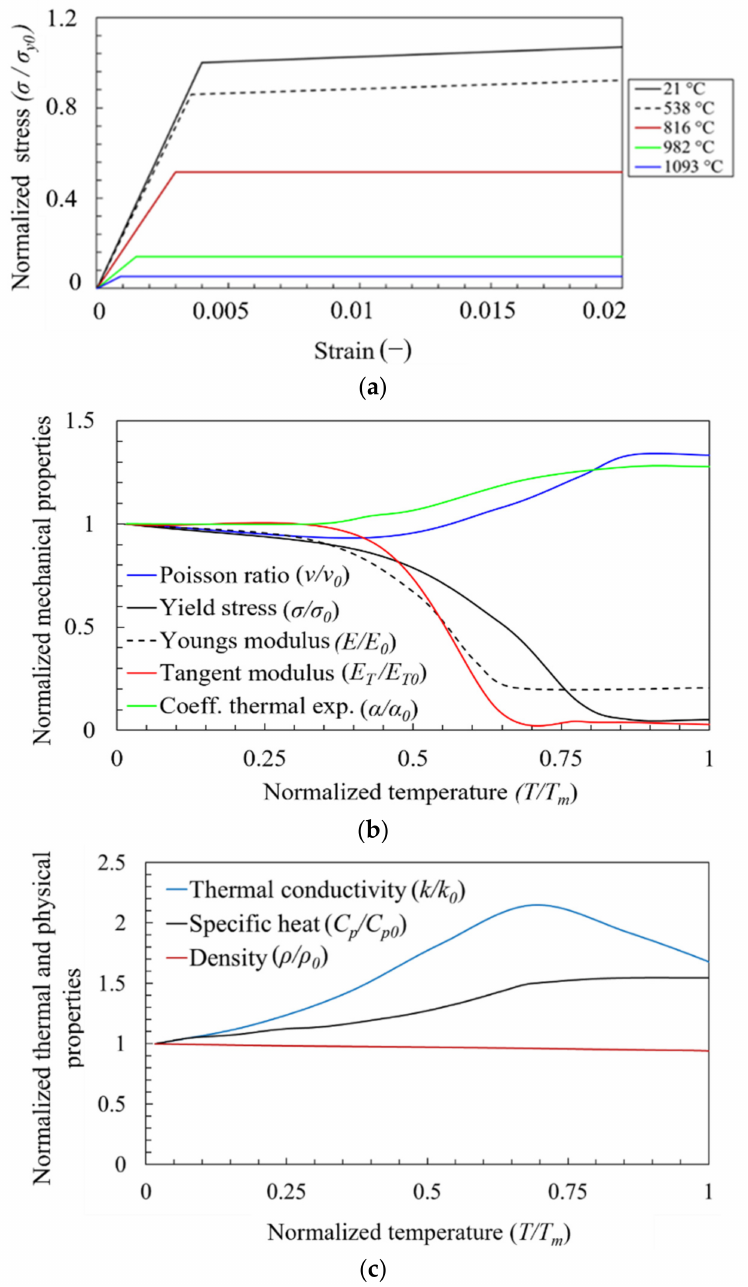
Figure 2. Normalized temperature-dependent properties for IN718: ( a ) stress–strain curves, ( b ) mechanical properties, and ( c ) thermal and physical